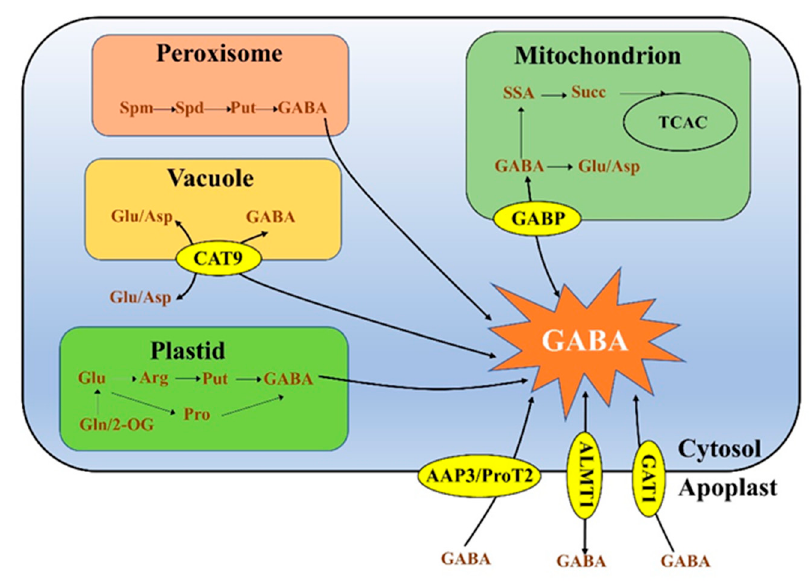
Figure 1. Model of distribution and transportation of GABA in plant cells.